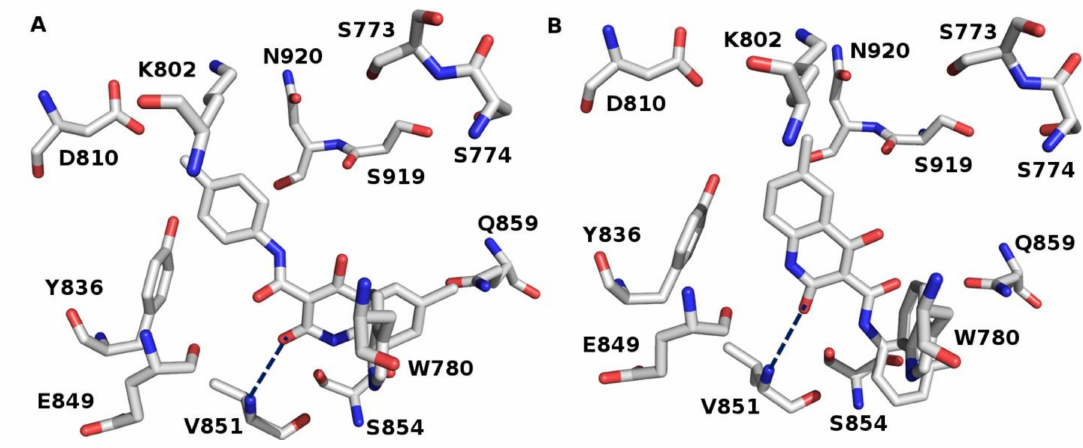
Figure 5. Binding geometries of ( A ) 13 and ( B ) 15 in the kinase site of 2RD0. H-bonds are depicted by blue dotted lines. H atoms are masked for clarification. Picture visualized by PYMOL [32].